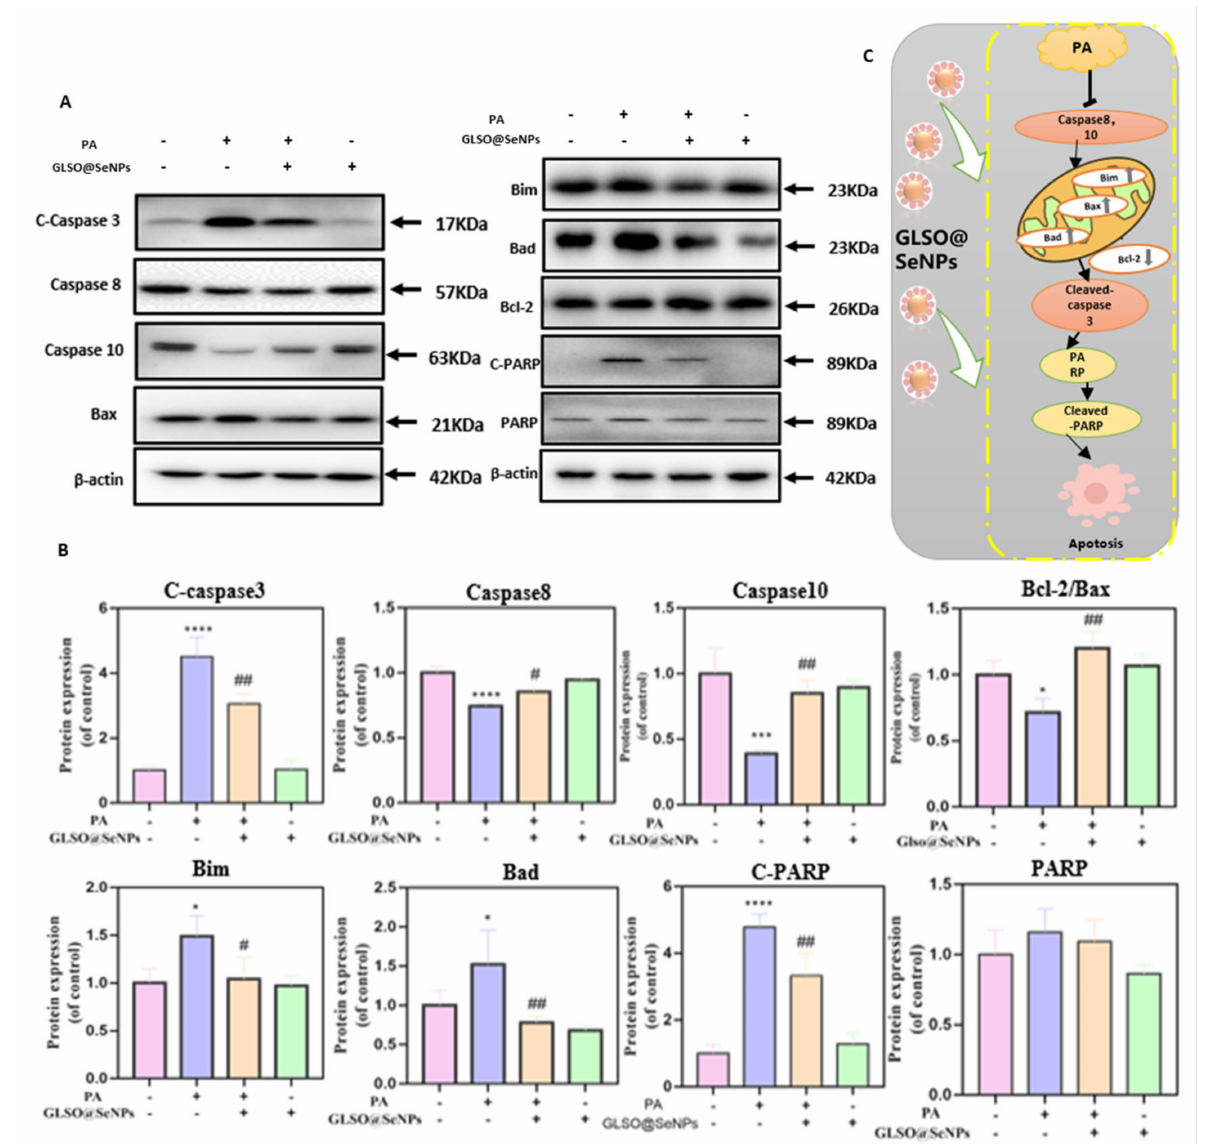
Figure 9. GLSO@SeNPs attenuate PA-induced apoptosis by inhibiting caspase activation in INS-1E cells. ( A ) Protein expression levels of c-caspase 3, caspase 8, caspase 10, Bax, Bim, Bad, C-PARP, and PARP. ( B ) Quantitative analysis of protein bands. (Firstly, the grayscale of the target strip was divided by the grayscale of the corresponding β -actin reference strip, and then the mean value of the control group was calculated. Finally, each group was divided by the mean value of the control group. The resulting values are used to make bar charts.) (* (#) p < 0.05 means the lowest significance, ## p < 0.01 means moderate significance, *** p < 0.001 means high significance, **** p < 0.0001 means the highest significance.) ( C ) Schematic diagram of the apoptosis signaling protein